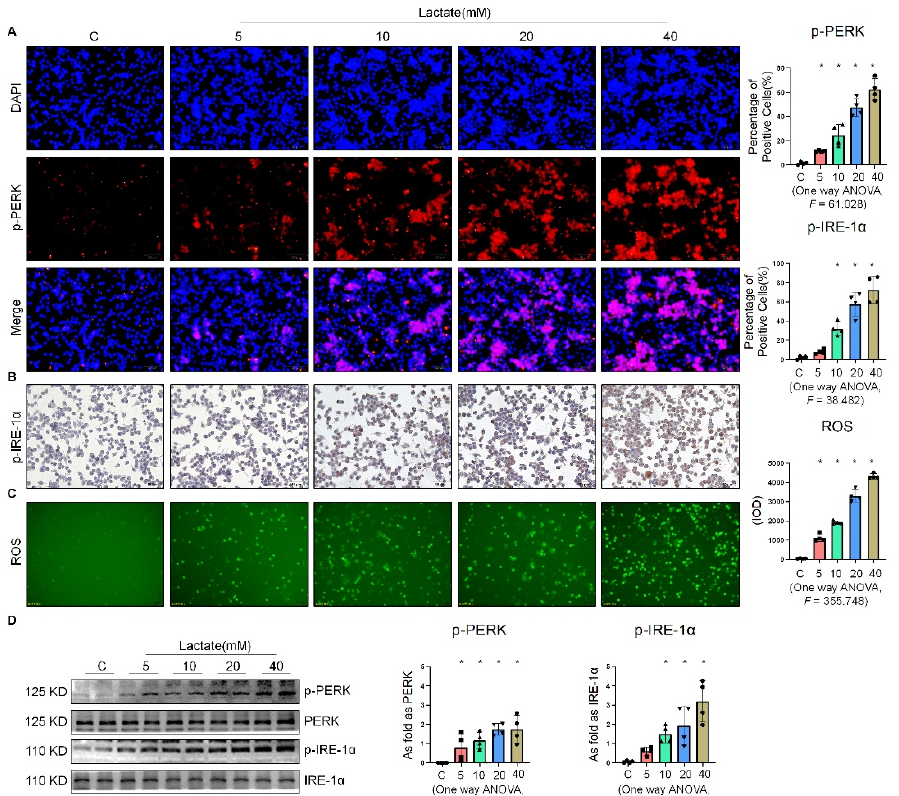
Figure 4. Lactate promoted ER stress in macrophages. ( A ) Expression of p-PERK in NR8383 cells treated with lactate at different doses observed by IF staining (scale bar = 50 µm). ( B ) Expression of p-IRE-1 α in NR8383 cells treated with lactate at different doses observed by IHC staining (scale bar = 50 µm). ( C ) Intracellular ROS production in NR8383 cells treated with lactate at different doses observed by DCFH-DA staining (scale bar = 100 µm). ( D ) Levels of p-PERK and p-IRE-1 α in NR8383 cells treated with lactate at different doses measured by Western blotting. * Compared with control group, p < 0.05. All data are presented as the mean ± SD, n = 4 per group.